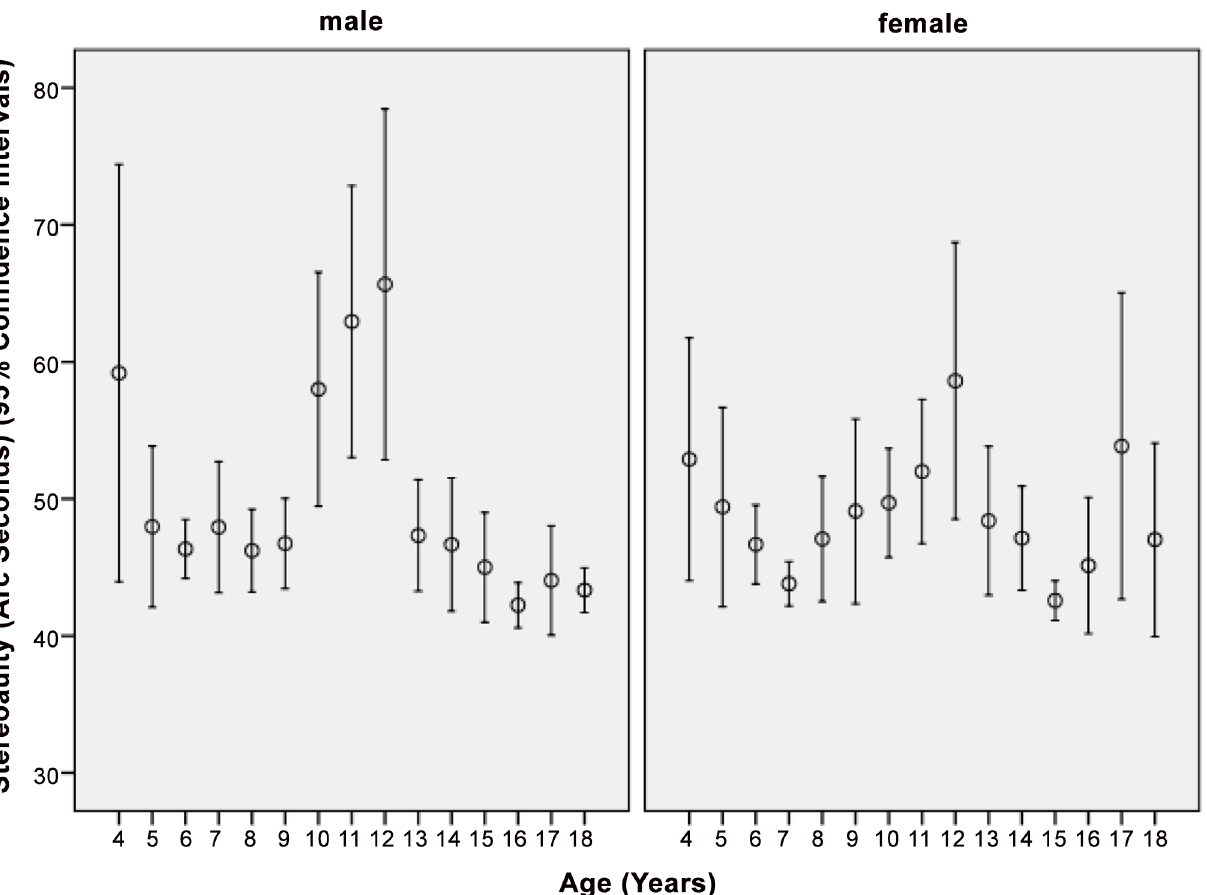
Fig 4. Distribution of Stereoacuity Measured as Minimal Angle of Binocular Disparity in the Shandong Children Eye